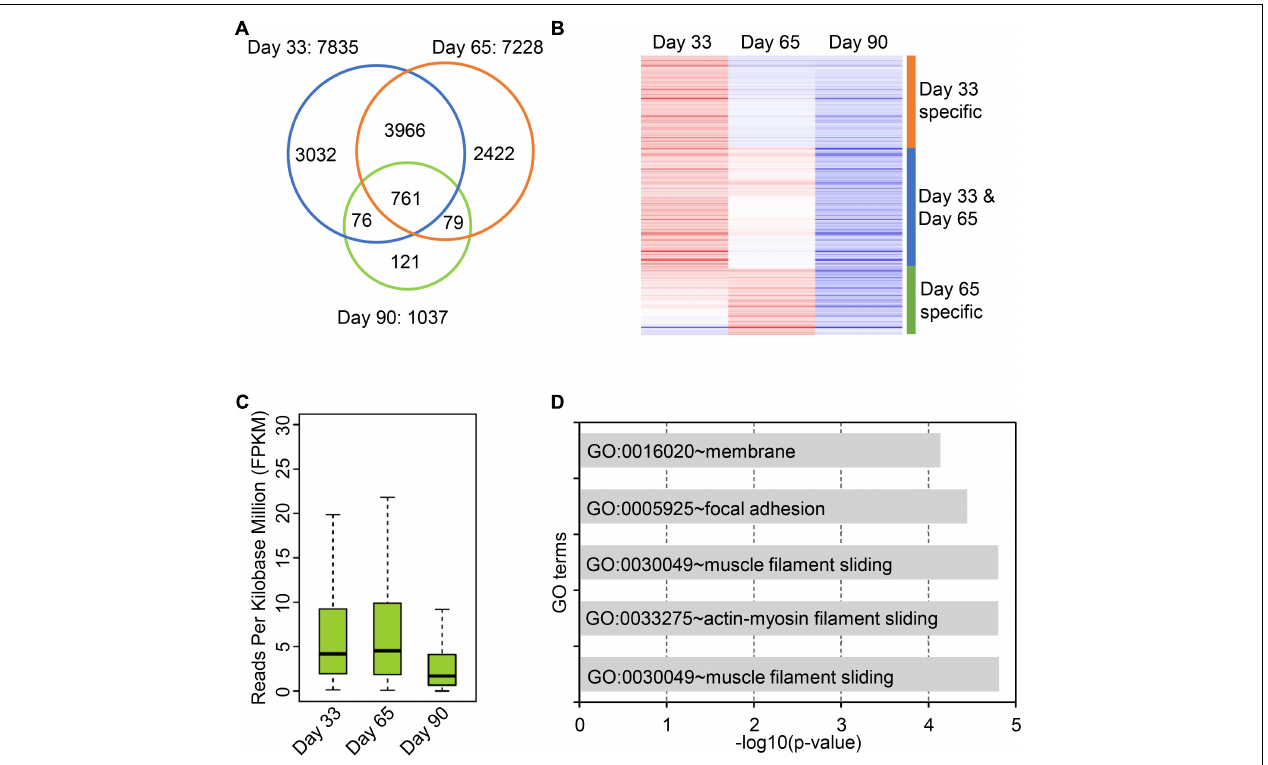
FIGURE 3 | Expression dynamics of circular RNAs in embryonic skeletal muscle development. (A) Venn diagram shows the overlap of circRNAs on 33, 65, and 90 days of gestation. (B) Heatmap shows the expression dynamics of circRNAs on 33, 65, and 90 days of gestation. (C) The boxplot shows the expression of circRNAs on 33, 65, and 90 days of gestation. (D) Bar chart shows GO term enrichment analysis of the host gene of